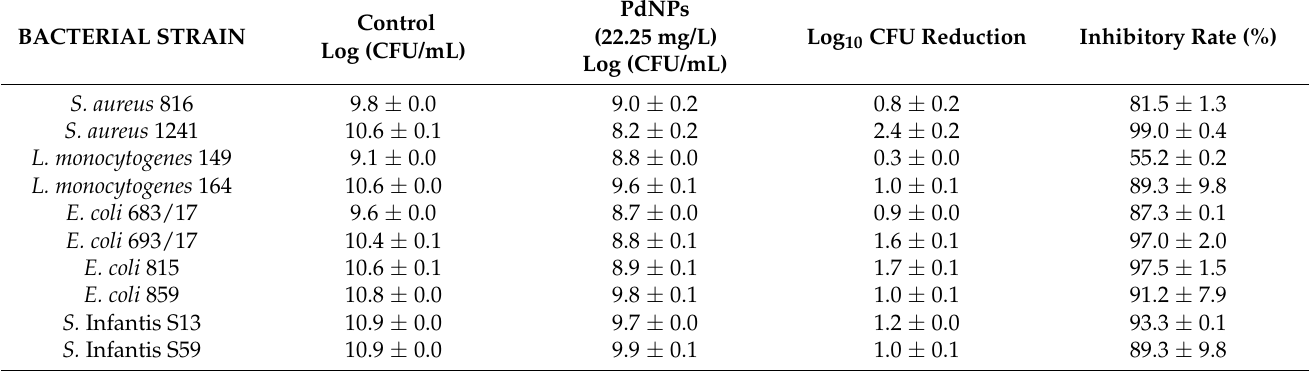
Table 5. Reduction in viable colony counts caused by 24 h exposure to PdNPs (22.25 mg/L). Data represent the mean of at least four independent